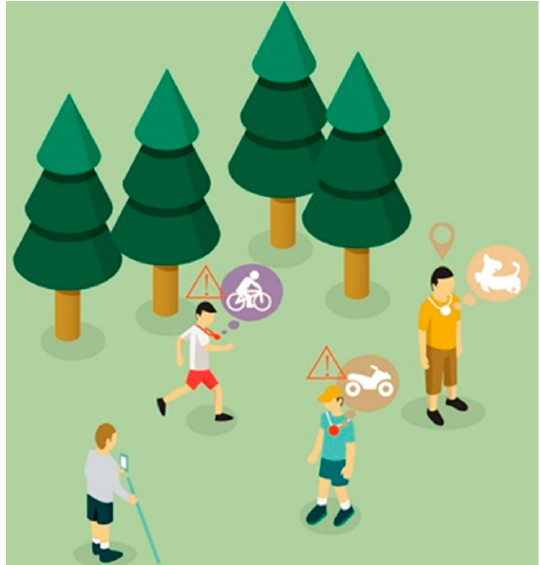
Figure 3. Scene diagram of the use of mobile audio accessories.